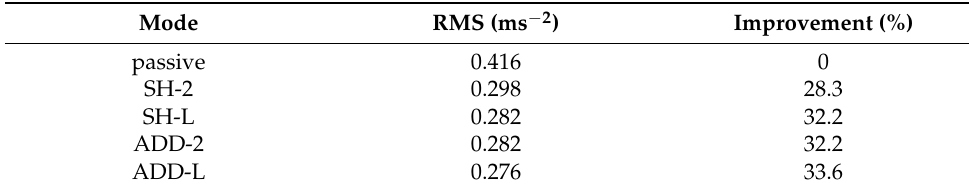
Table 4. Carbody lateral acceleration RMS (ms − 2 ) for each mode and percentage reduction compared to passive mode.